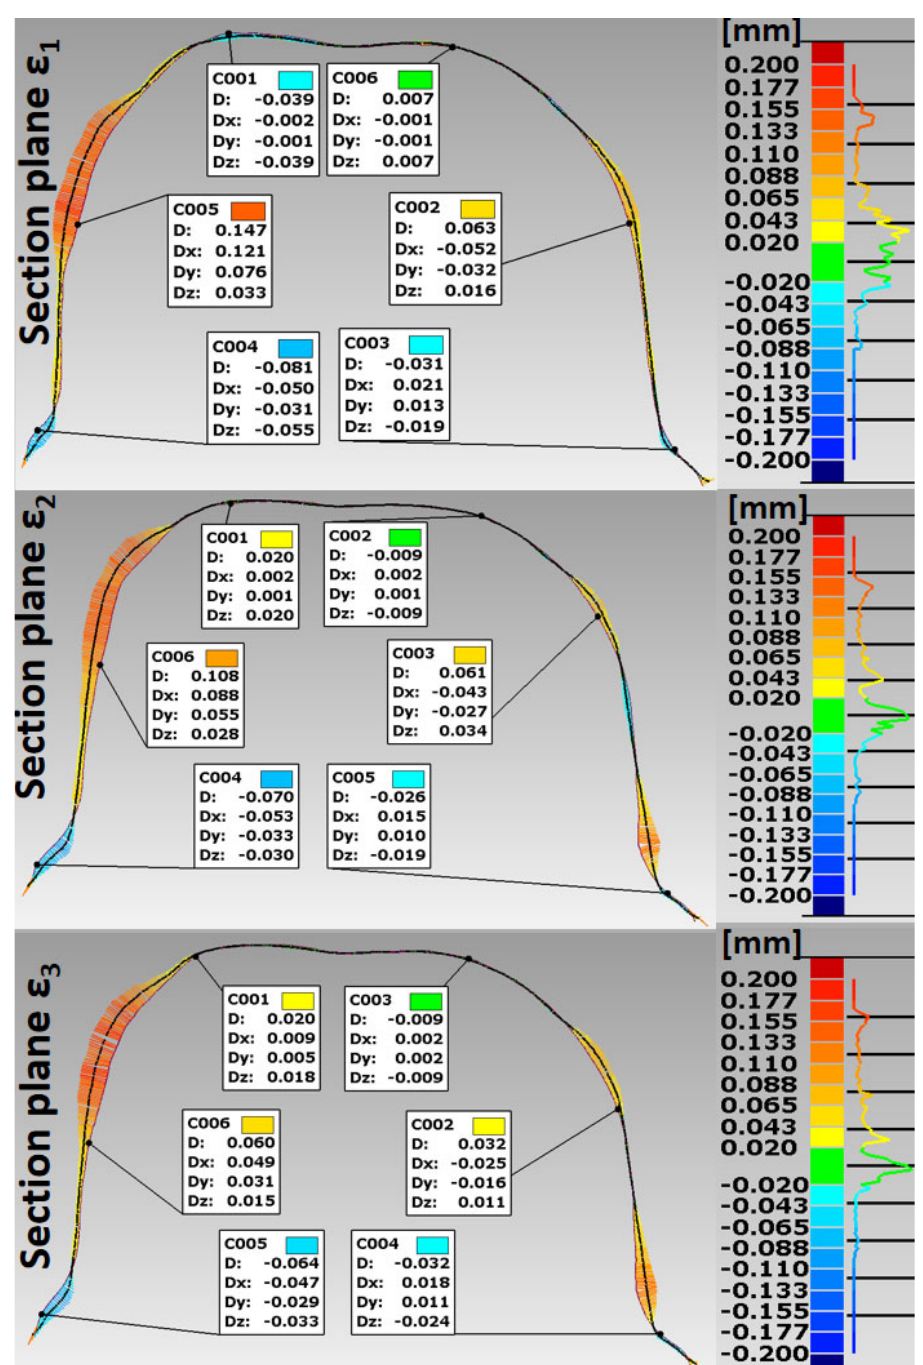
Figure 15. Distribution of deviations in the marginal and internal fit of a crown made of Ti6Al4V alloy in the milling for molar tooth